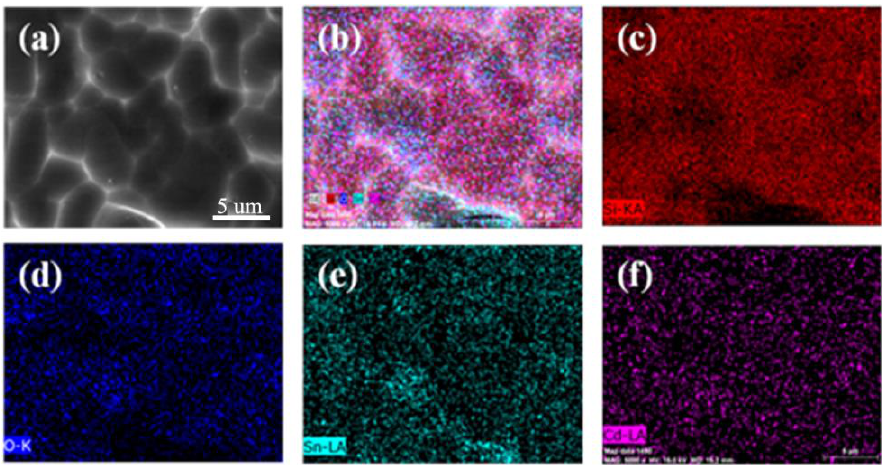
Figure 2. ( a ) FESEM of the composited SnO 2 /CdO/Si DLSC , ( b ) the element mapping of all detected elements, ( c ) Si, ( d ) O, ( e ) Sn, and ( f ) Cd elements.